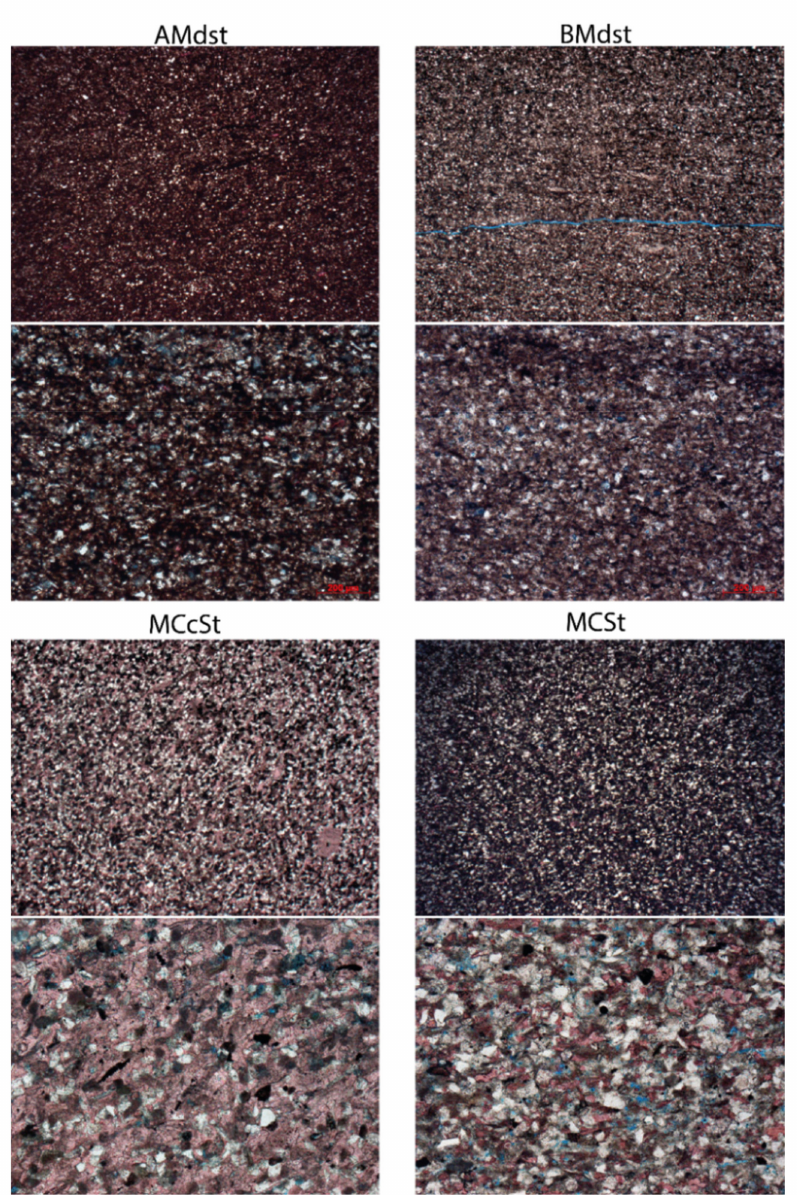
Figure 2. Examples of images in the petrographic thin-section test set and their corresponding labels. The figure shows two images for each one of the classes. The top image of each class is taken with a magnification zoom of 2.5 × , the bottom image with 10 × . The red labels in the bottom right-hand corner are randomly present in some 10 × images, indicating 200 µ m. Class names and descriptions are provided in Table